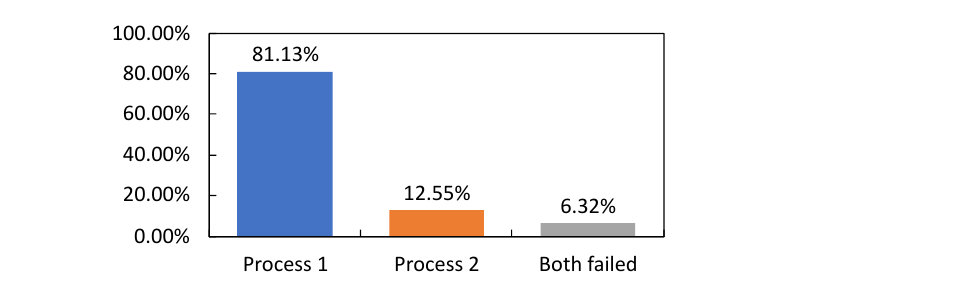
Figure 10. Average percentage of the framework processes able to meet the computation deadline.